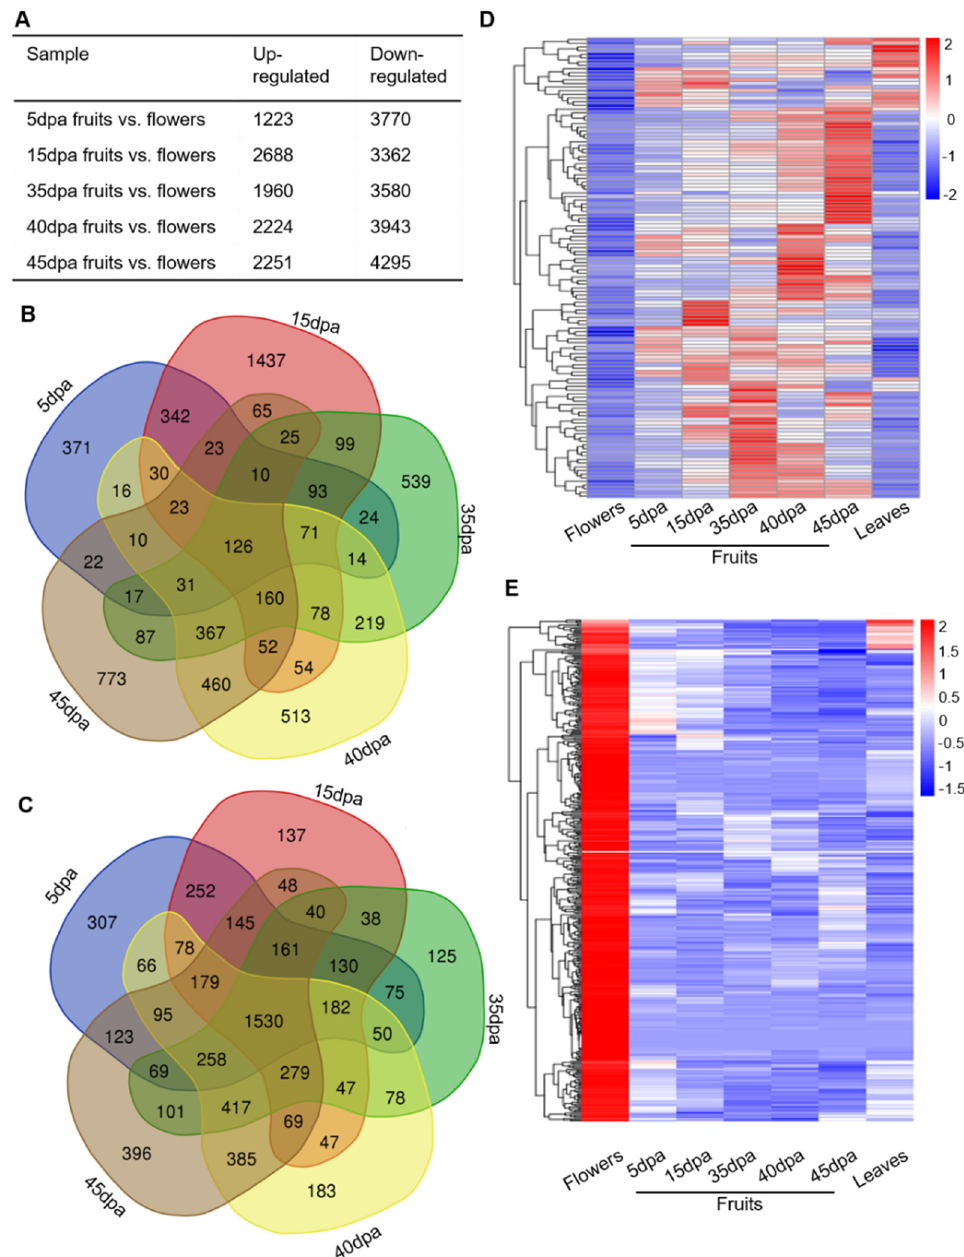
Figure 4. Characterization of differentially expressed lncRNAs between indicated comparisons. ( A ) The number of up- regulated and down-regulated lncRNAs in indicated fruit samples compared to flowers. Flowers were sampled at the day of flowering. ( B , C ) Venn diagram shows the commonly up-regulated ( B ) and down-regulated ( C ) lncRNA in tomato fruits at different developmental stages compared to flowers. ( D ) Heatmap representation of the 126 lncRNA levels of commonly up-regulated in ( C ). ( E ) Heatmap representation of the lncRNA levels of commonly down-regulated in ( D ). The lncRNAs with PFKM value more than 1 in flowers were collected to do the heatmap representation in ( E ).